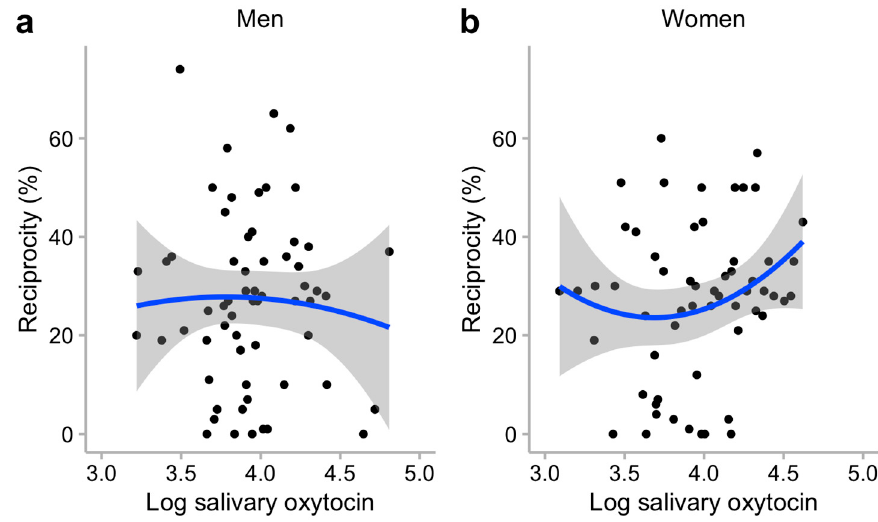
Figure 3. The relationship between salivary oxytocin (log-transformed) and reciprocity in ( a ) men and ( b ) women.